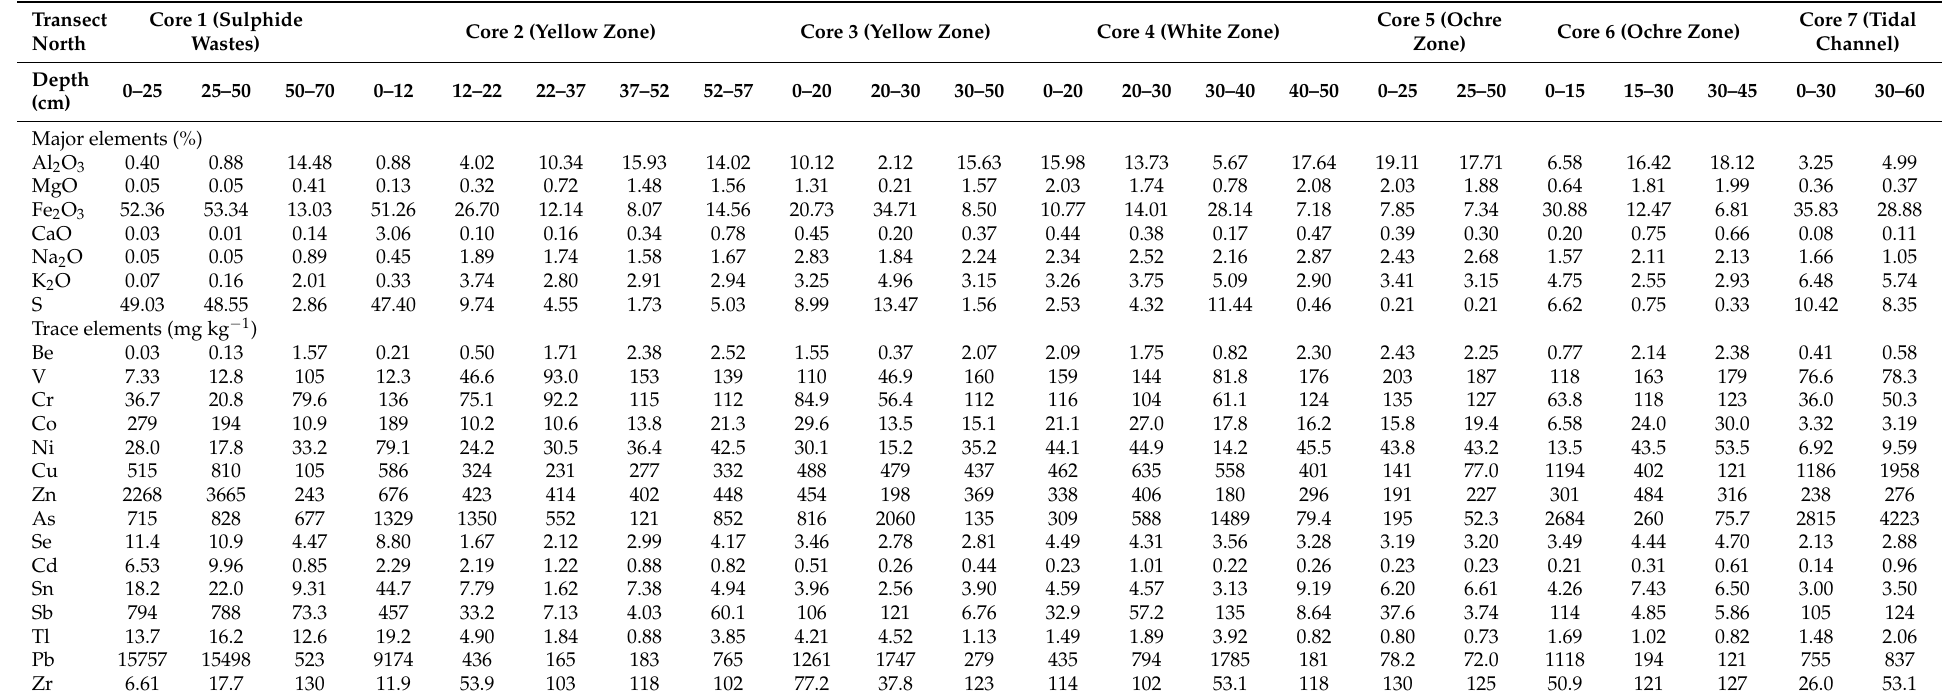
Table 2. Chemical composition of major and trace elements of the soil core samples collected along the north